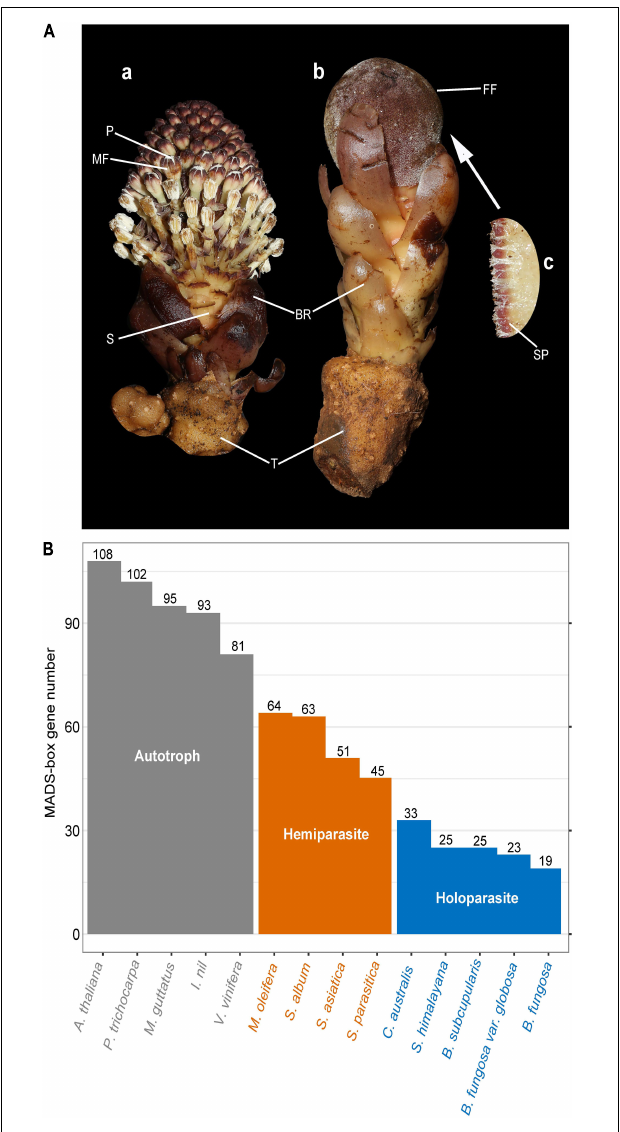
FIGURE 1 | Morphological traits of Balanophora plants and MADS-box gene number. (A) Morphological structure of Balanophora plants ( B. fungosa var. globosa ). (a,b) Extremely simplified male plant and the female plant. (c) Female flower structure was observed under an electron microscope. FF, female flower; MF, male flower; S, stem; BR, bract; T, tuber; SP, spadicale; P, pollen. Image courtesy of Runxian Yu (CC BY-SA 2.0). (B) The number of MADS-box genes in B. subcupularis , B. fungosa var. globosa , and reference species. Fourteen species were selected according to the degree of parasitism and genetic relationship. Gray, orange, and blue indicate autotrophic plants, hemiparasite, and holoparasite, respectively. The bar chart shows the number of MADS-box genes in each species. The iTAK (http://itak.feilab.net/cgi-bin/itak/online_itak.cgi) and plantTFdb (http://planttfdb.gao-lab.org/prediction.php) programs were used to identify the MADS-box genes of these species.